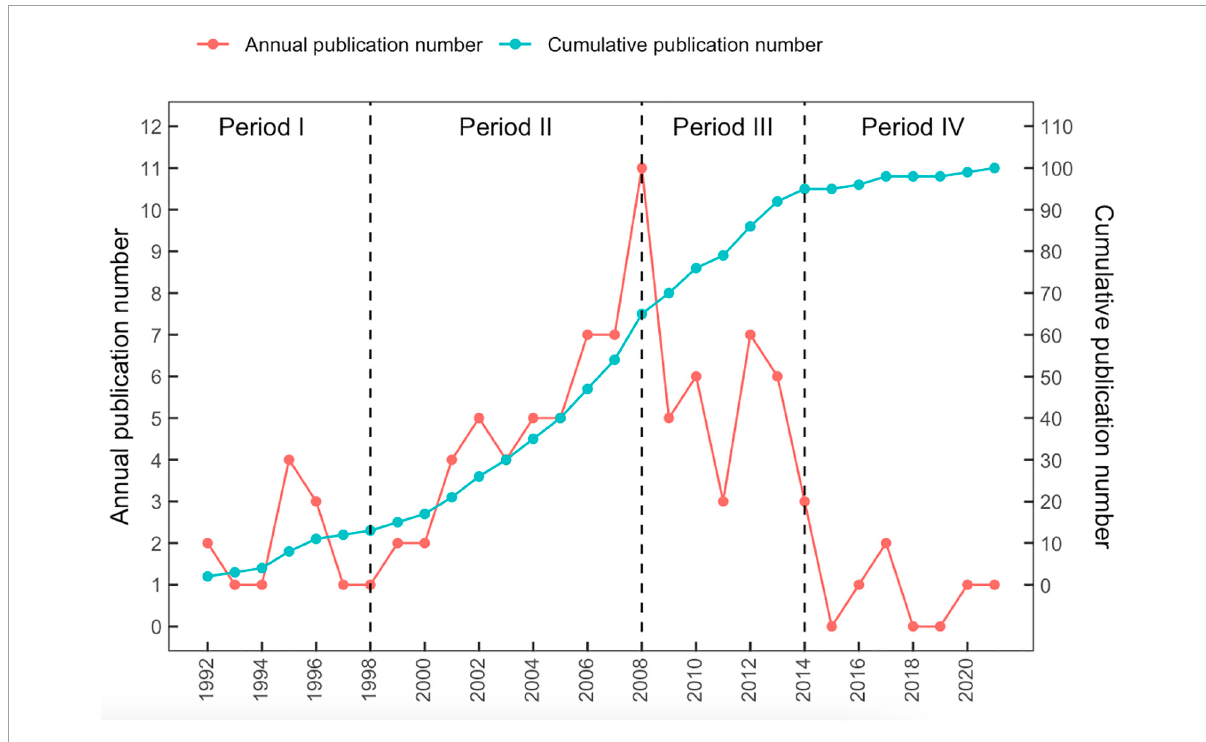
FIGURE1 Number of top-cited 100 publications by